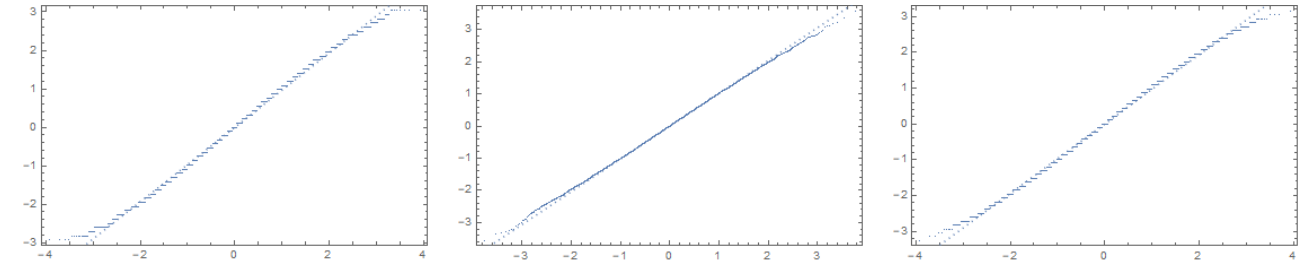
Figure 4. Quantiles plot against normal distribution for κ 44 , κ 58 and κ 74